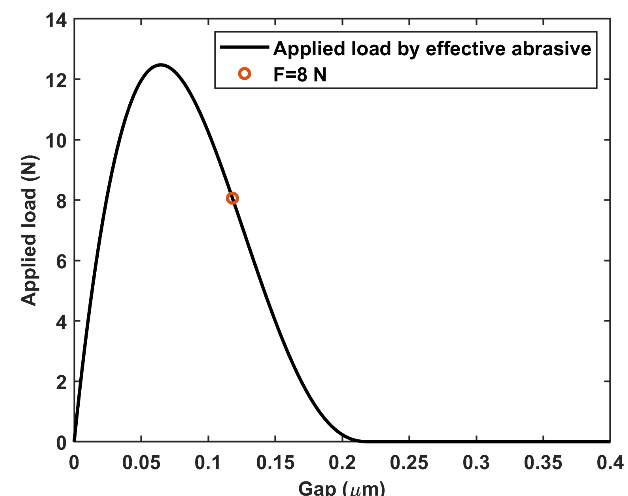
Figure 12. Applied load as a function of gap calculated by using Equation (12). As described in Section 3, 8 N was adopted as total applied load, and the gap value was 0.1185 μ m (marked by an orange circle), based on the curve.